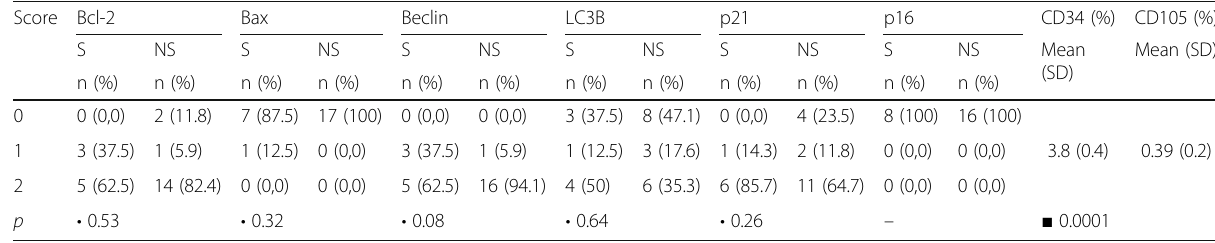
Table 2 Distribution data for Bcl-2, Bax, Beclin, LC3B, p21 and p16 used for immunohistochemistry according to established scores and p value for difference between solid and non-solid